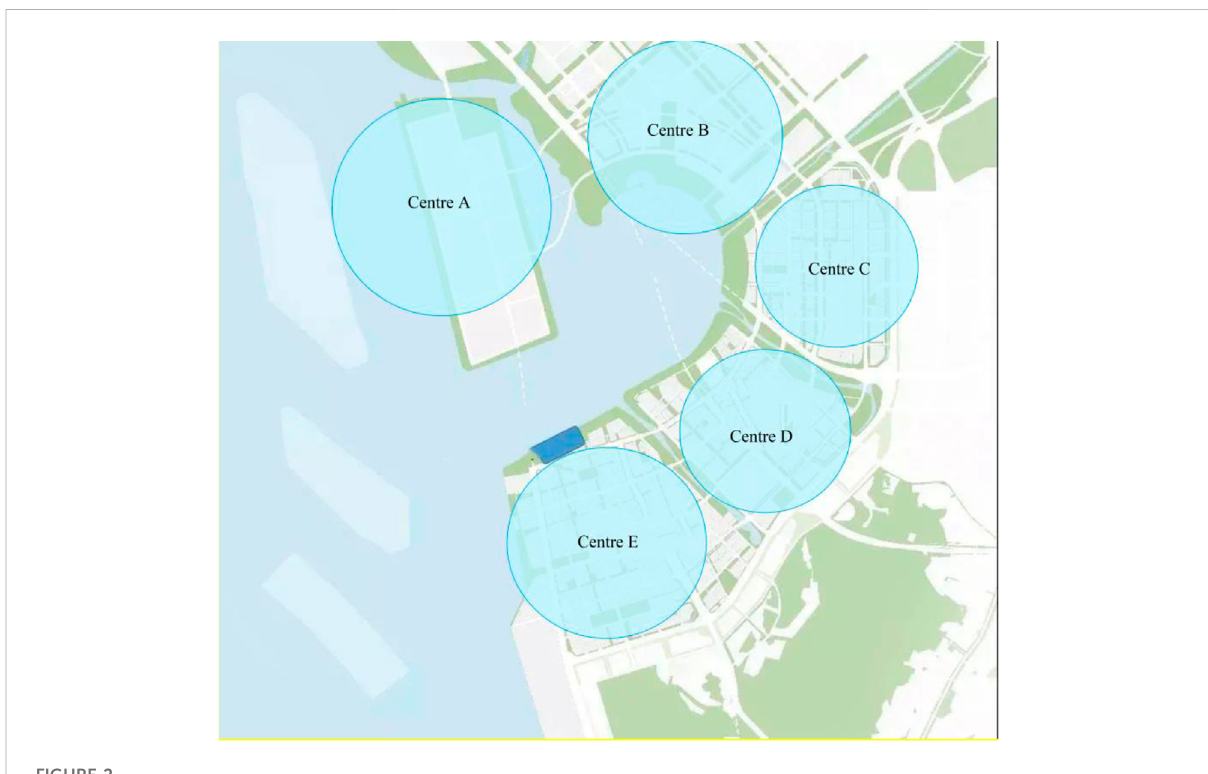
FIGURE 2 Qianhai cooperation zone and Bao ’ an central